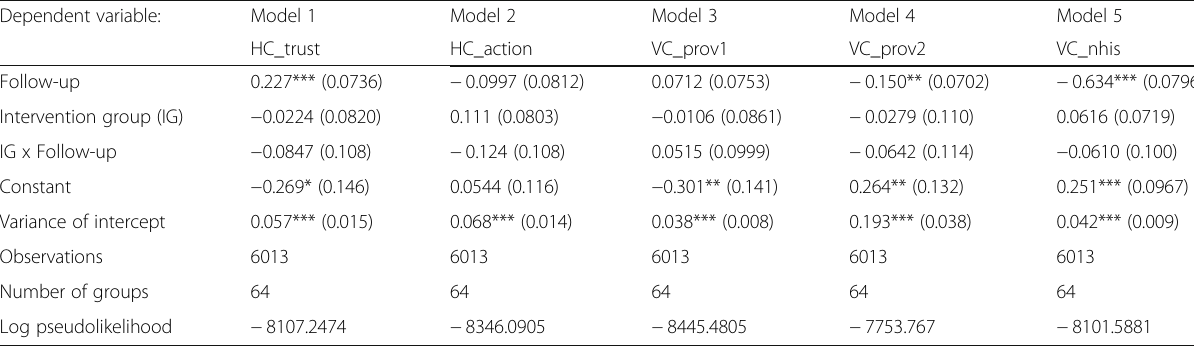
Table 3 The effect of the interventions on the level of social capital aspects